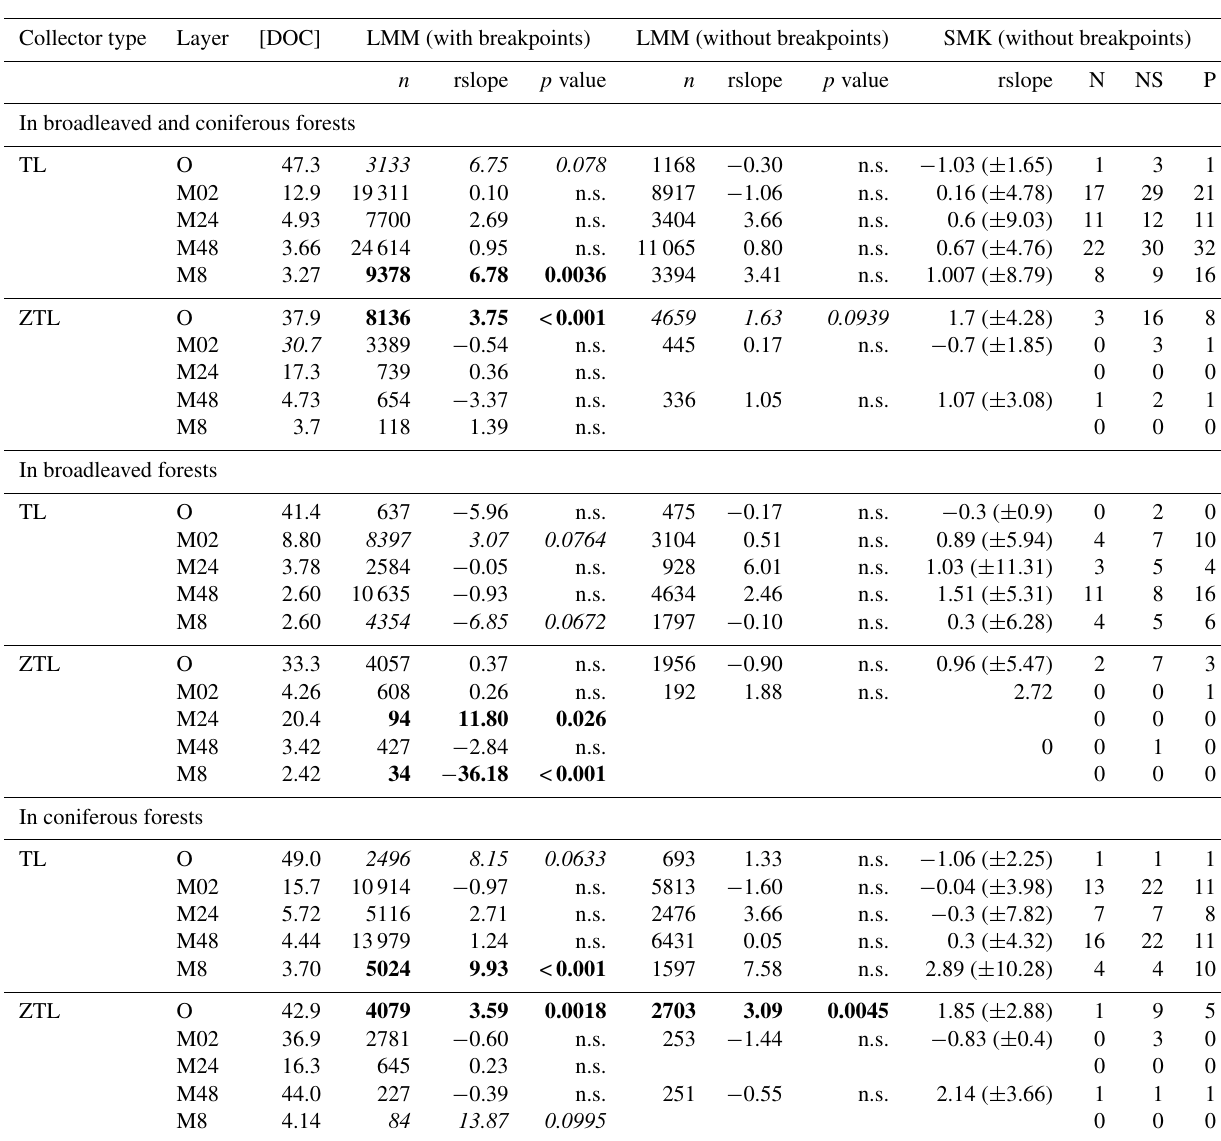
Table 1. Temporal trends of DOC concentrations obtained with the linear mixed models (LMM) built for different forest types, soil depth intervals and collector types with the entire dataset (with breakpoints) and with the dataset without time series showing breakpoints (without breakpoints) and the seasonal Mann–Kendall (SMK) tests. The table shows the median DOC concentrations in mgL − 1 ([DOC]), relative trend slope (rslope in %yr − 1 ), the number of observations ( n ) and the p value. For the SMK tests, the number of time series showing significant negative (N), non-significant (NS) and significant positive (P) trends is shown and the interquartile range of the rslope is between brackets. LMMs for which no statistically significant trend was detected ( p >0.1) are represented in roman type, the LMMs for which a significant trend is detected are in bold ( p <0.05) and in italics (0.05< p <0.1) (O: organic layer; M02: mineral soil 0–20cm; M24: mineral soil 20–40cm; M48: mineral soil 40–80cm; M8: mineral soil >80cm; TL: tension lysimeter; ZTL: zero-tension lysimeter; n.s.: not